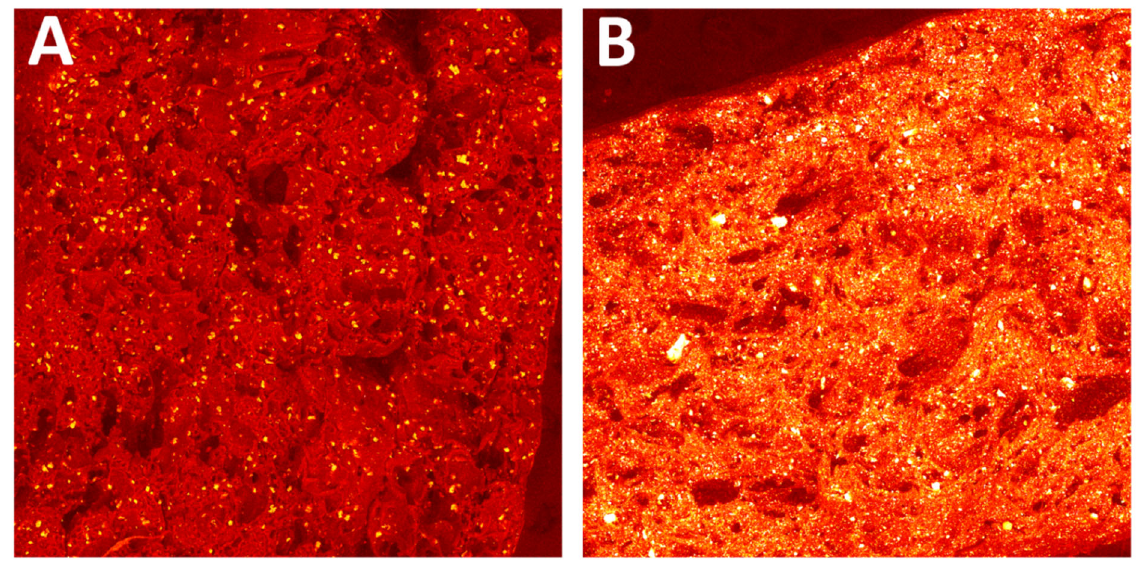
Figure 17. Dispersion of ceramic fillers in the polymer matrix for ( A ) PA12_Al 2 O 3 _S and ( B ) PA12_ZrO 2 NS